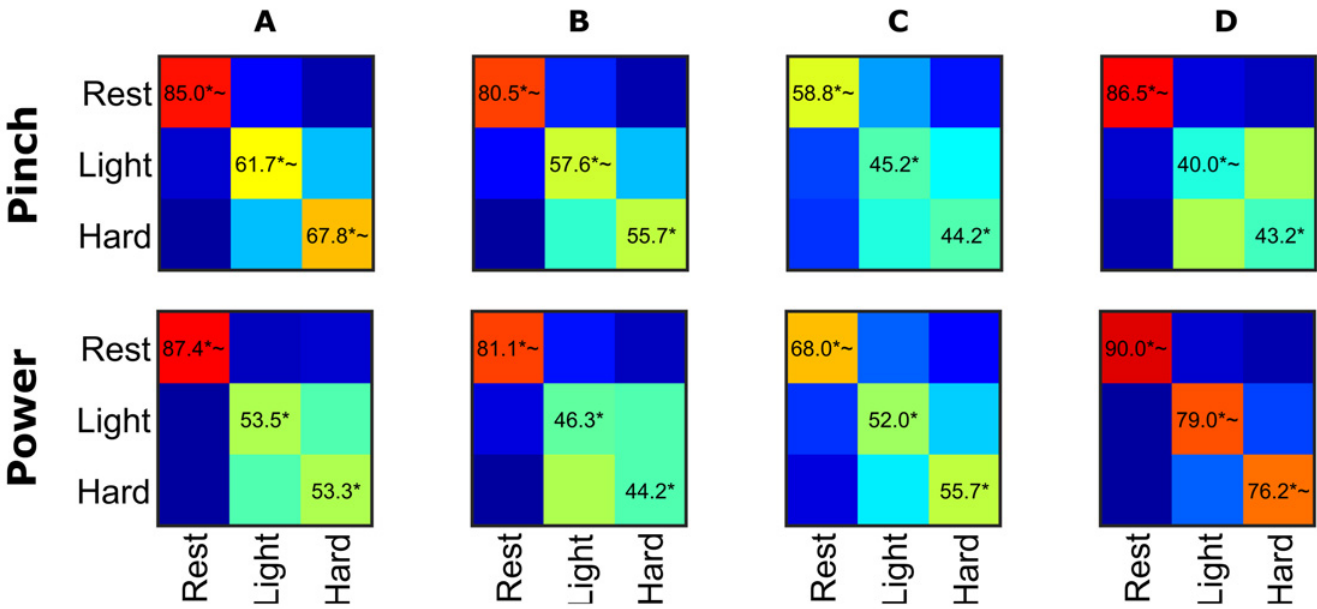
Fig 5. Rest versus Light versus Hard Classification Accuracies. Confusion matrices of light versus hard versus rest classification for each participant (columns) in the lateral pinch and power configurations (rows) using sequential feature selection and two levels of cross-validation. Features were averaged across a time window of -400 ms to +400 ms centered on force onset or 1 second after the rest cue. All participants showed the ability to differentially modulate neural activity between rest and force with high accuracy, but were less adept at differentially modulating neural activity between force levels. * denote significance above chance classification (1 in 3) using false-discovery rate adjusted p-values < 0.05 while ~ denotes a more stringent significance from 50% to see if light vs hard forces were significantly